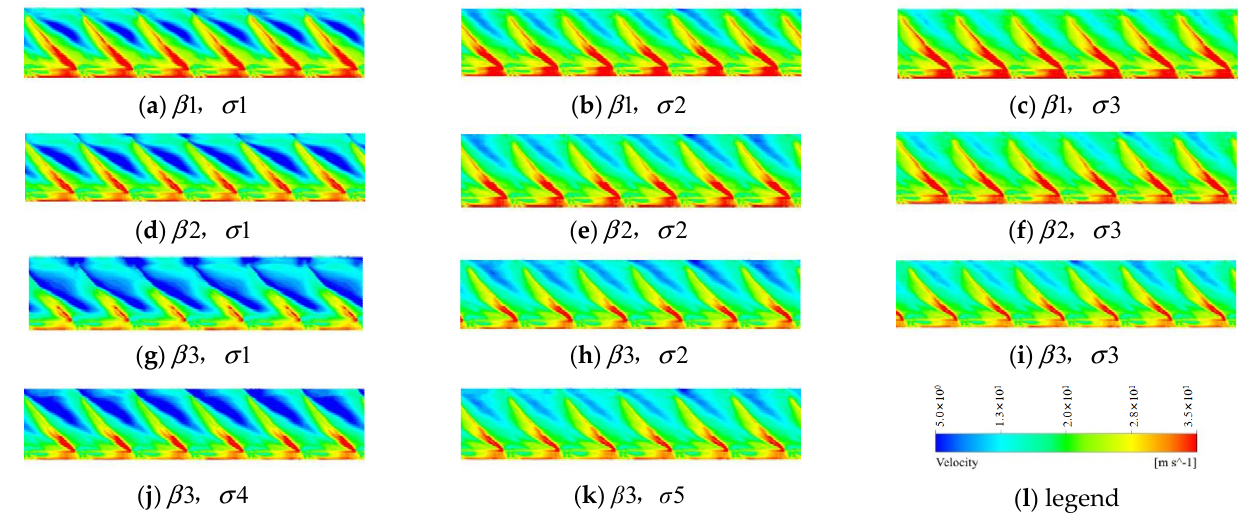
Figure 22. Velocity of the rotor blade tip at different oblique angles and cavitation numbers.